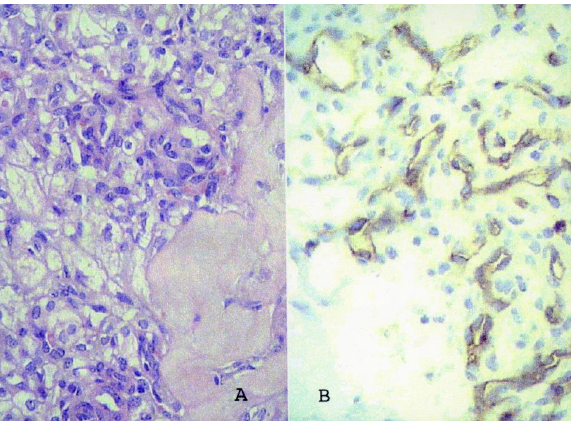
Figure 2 – A) Clusters of tumor cells separated by hyalinized stroma (HE, X400). B) Immunohystochemistry staining showing strong diffuse positive staining (brown) for CD34